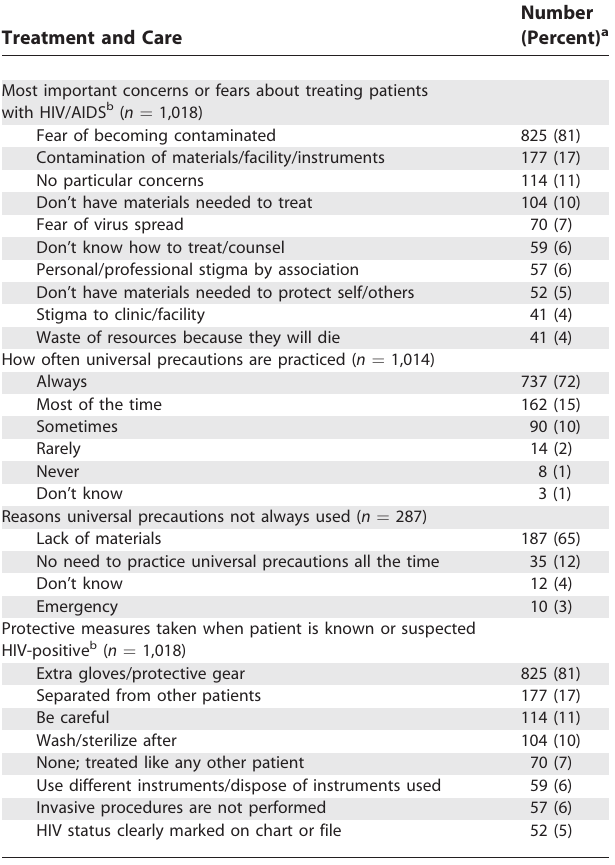
Table 6. Assessment of Practices toward Patients with HIV/AIDS Number (Percent) a